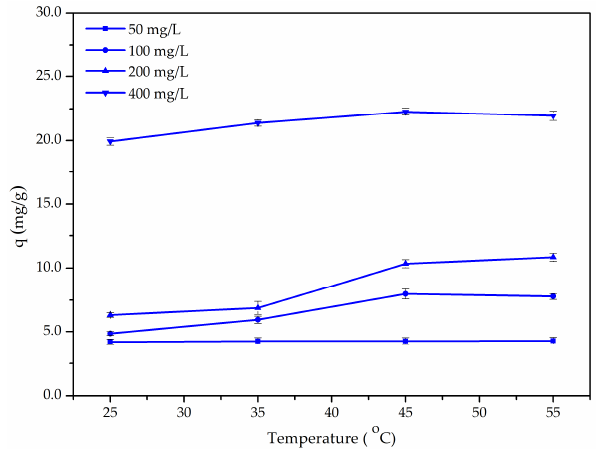
Figure 7. Effect of temperature on the adsorption capacity (pH = 5, t = 8 h, n = 100 rpm).